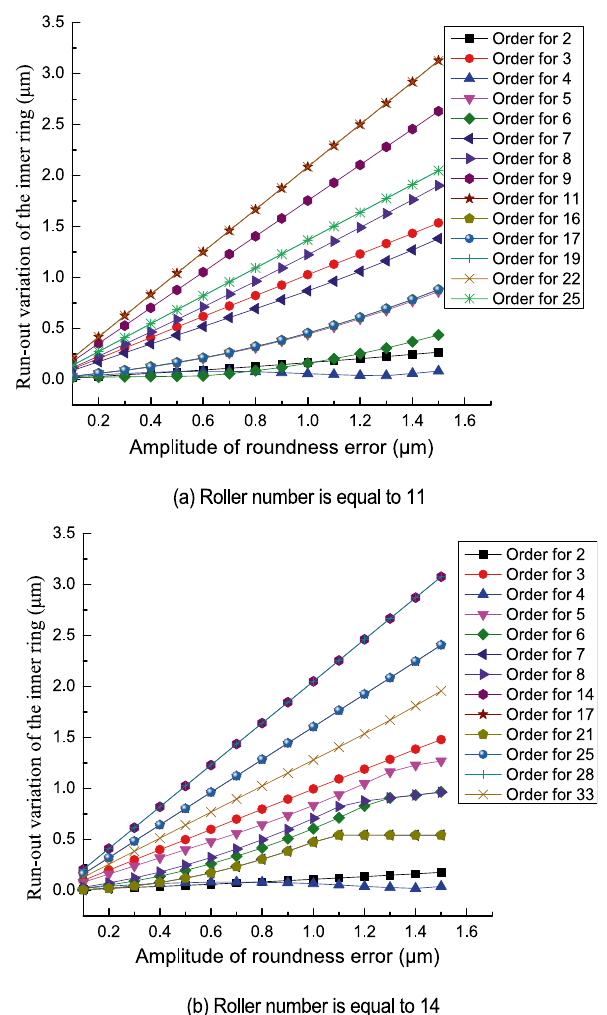
Figure 12. Effect of the amplitude of roundness error in the outer raceway on the run-out variation of the inner the order is an integer multiple of the roller number in the machining process of the inner and outer raceways to improve the rotational accuracy of cylindrical roller bearings. 2. The effect of the even-order roundness error in the rollers on the motion error of cylindrical roller bearings is significant, while the odd-order roundness error in the rollers does not affect the motion error. Even-order harmonic components in the rollers should be strictly controlled in order to improve the rotational accuracy of the assembled bearing. 3. Increasing the roller number does not always decrease motion error of the cylindrical roller bearings because of the coupling effect of the roller number and roundness error of the bearing components. The roller number should be matched with the harmonic order of the bearing components to effectively improve the rotational accuracy of the assembled bearing.